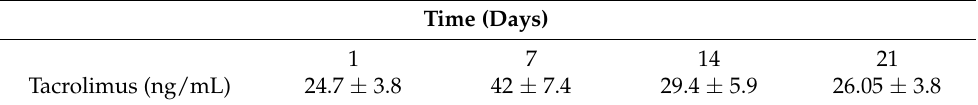
Table 3. Whole blood concentration of tacrolimus: In vivo drug release results from mixed hydrogels containing 10 mg/mL